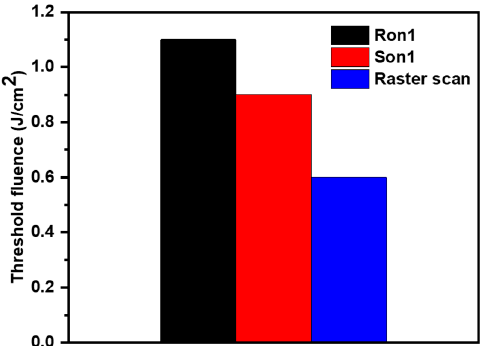
Figure 7. The comparison of damage threshold fluence values on the sample surface by three test methods.